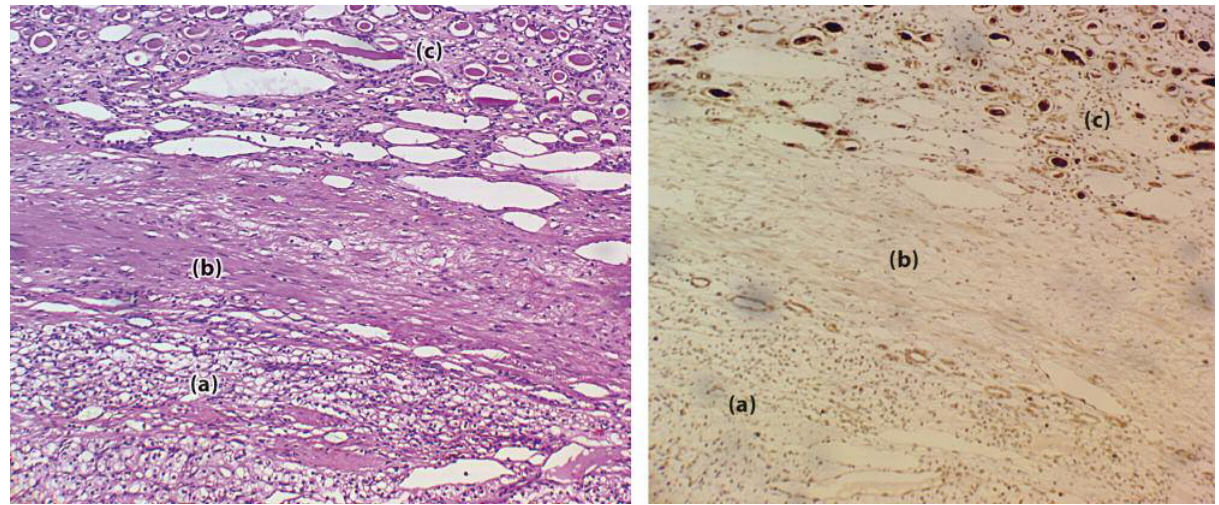
Figure 1 (Left panel) Representative image of Hematoxylin and Eosin-stained sections of ccRCC. (a) Τ umor Τ issue, (b) Τ umor pseudo- capsule, (c) Normal Tissue. [Magnification x100]. (Right panel) Representative image of sections of ccRCC stained with anti-CYLD